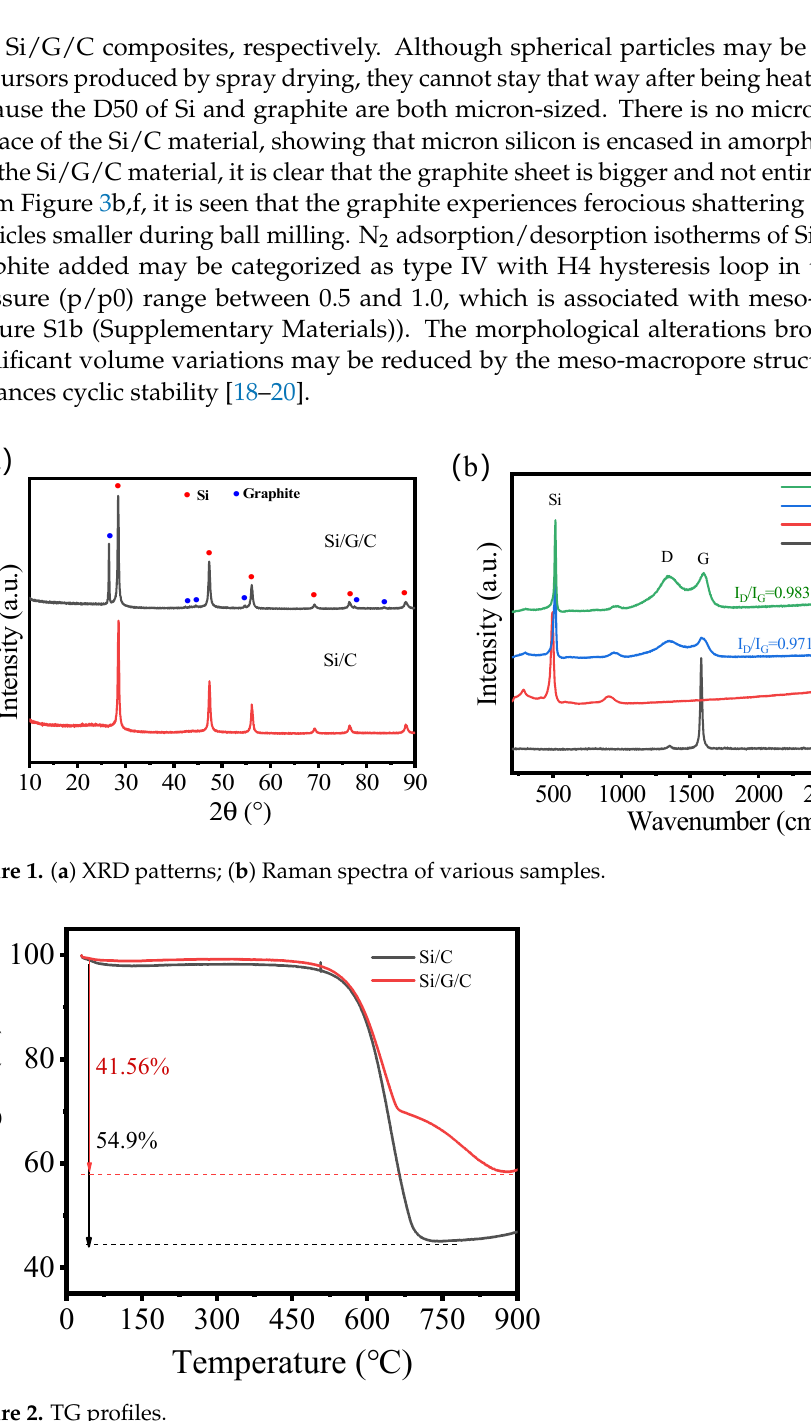
Figure 2. TG profiles. equally throughout the composite, showing the components of the Si/G/C composite are evenly mixed. The amorphous carbon may efficiently enclose the Si and graphite particles inside it. It is stated that the inclusion of amorphous carbon on the surface of the composite would prevent the silicon particles from separating by providing effective constrain force and is favorable for the electrical transmission, thus, it may increase the electrochemical performance of the material. Figure 4b,c show the HRTEM pictures and the selected area electron diffraction (SAED) pattern of the composite, from which we can discern the main components of the